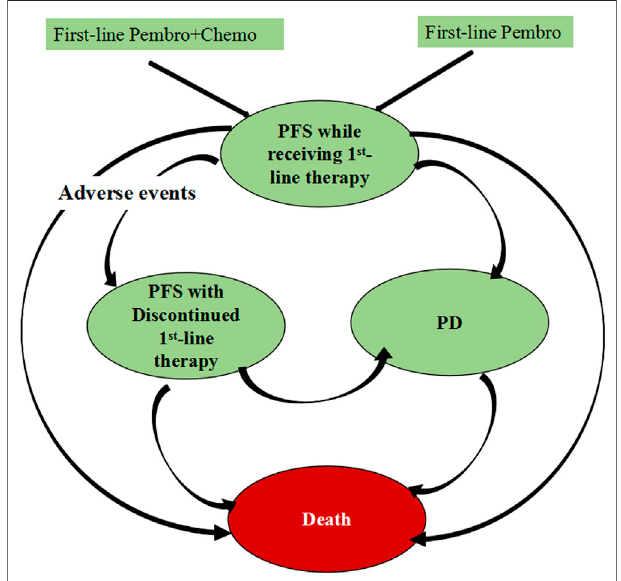
FIGURE 1 | Diagram of transitions between health states. PD, progressive